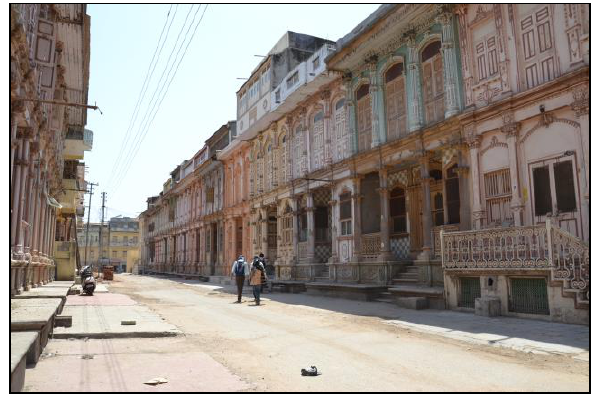
Figure 1. A traditional street from Sidhpur,